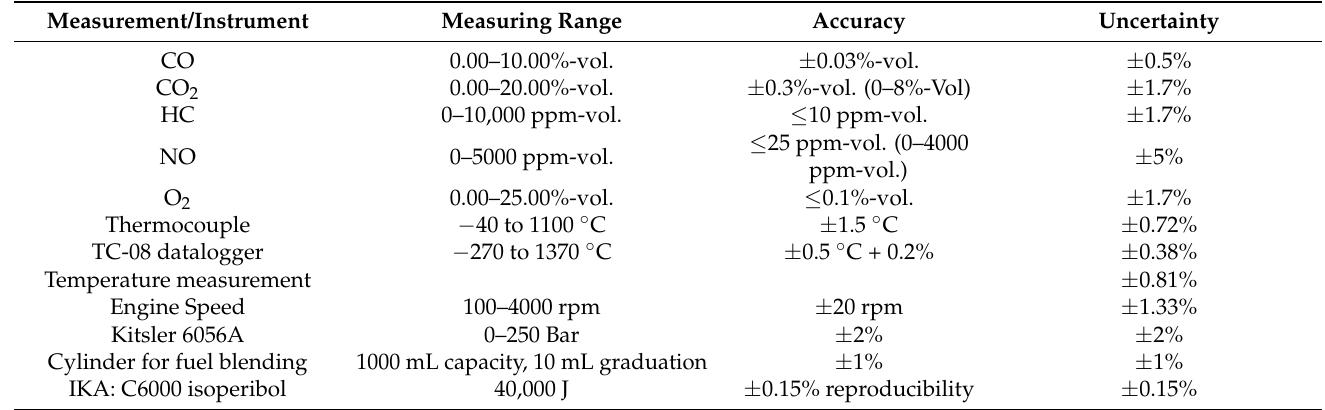
Table 3. Measurement accuracy and